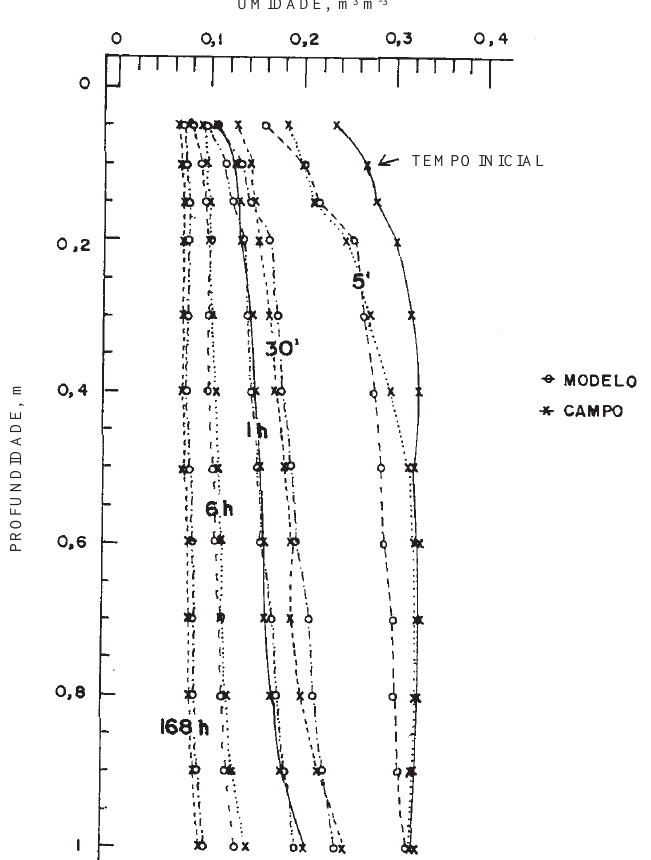
Figura 2. Umidade em função da profundidade para o experimento em areia marinha, obtida mediante modelo numérico de Prevedello (1996) e dados de campo de Cho et al. (1977), para os tempos de 5 e 30 minutos e de 1, 6 e 168